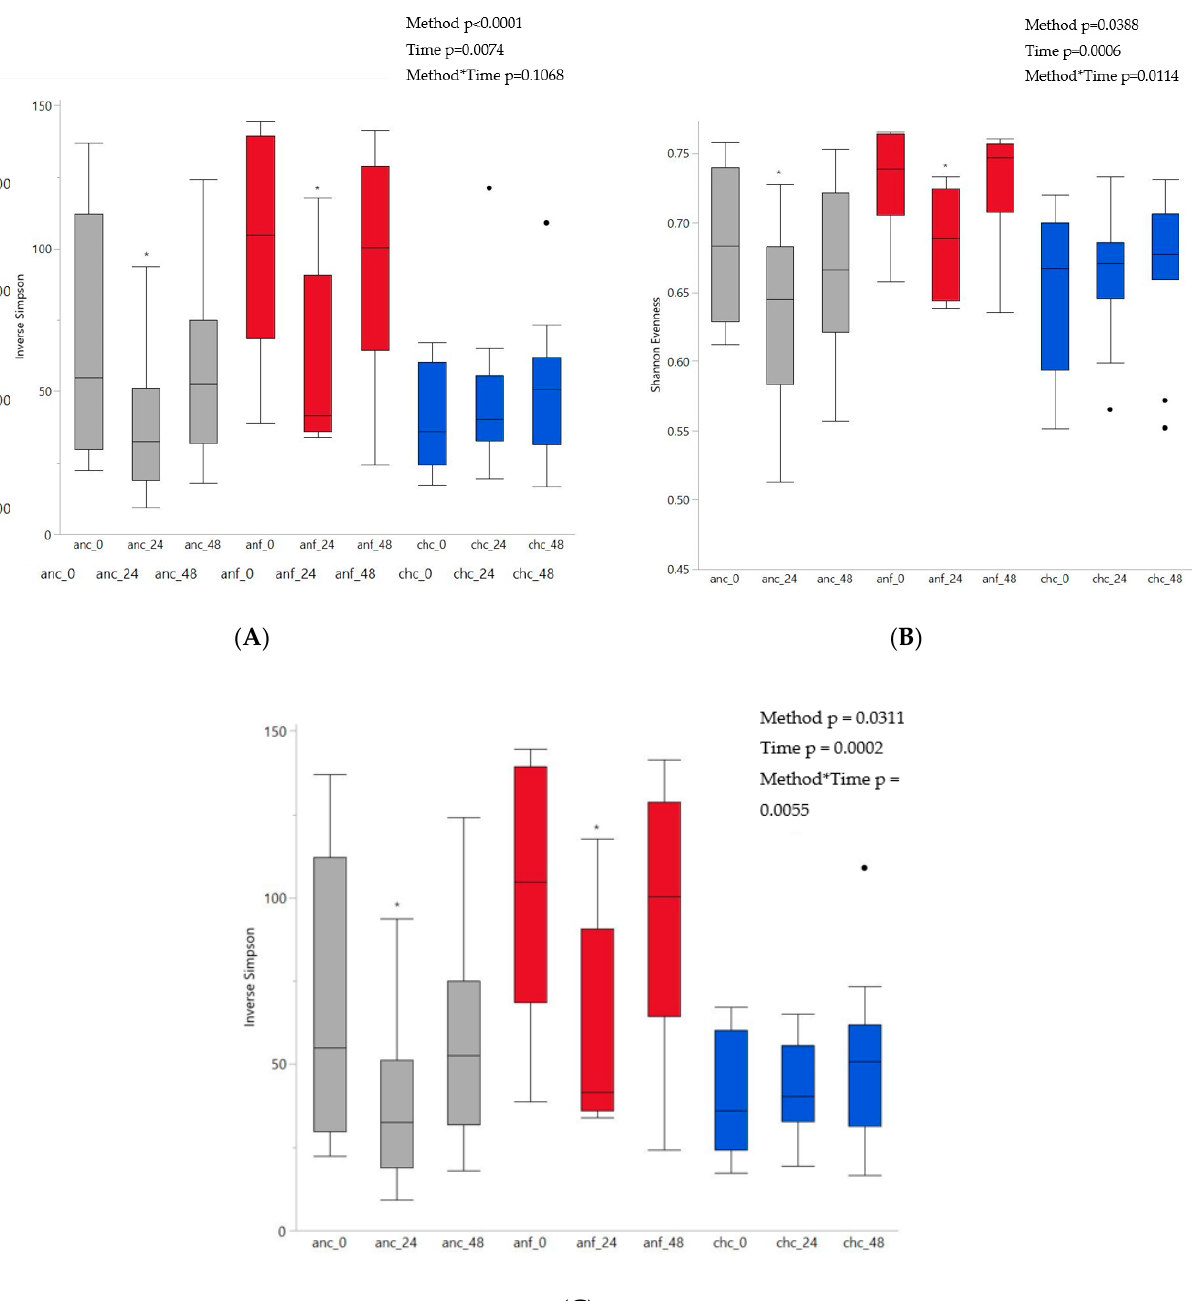
Figure 2. Comparison of alpha diversity indices. ( A ) Richness (Chao1); ( B ) evenness (Shannon evenness); ( C ) diversity (inverse Simpson), within fermentation methods over time. To inoculate 100 mL vessels maintained in an anaerobic chamber, 100 mL of cecal fluid (anc, n = 15, grey) or 5% fecal slurry (anf, n = 6, red) was used. To inoculate chemostat vessels maintained as batch fermenters (chc, n = 11, blue), 500 mL of cecal fluid was used. * represents a significant difference from time 0 within a fermentation method ( p <